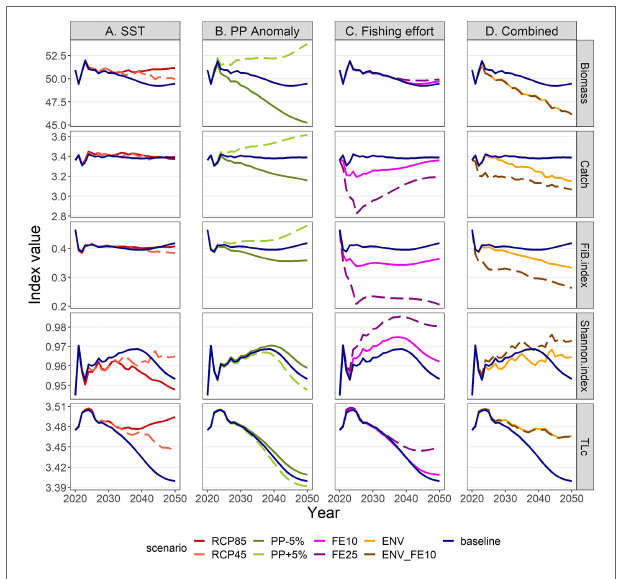
FIGURE 11 | Ecological and exploitation indices under scenarios related to (A) SST, (B) PP Anomaly, (C) fishing effort and (D) combination of drivers. The description of the scenarios is provided in Table 2 . Biomass in t*km -2 ; Catch in t*km -2 *y